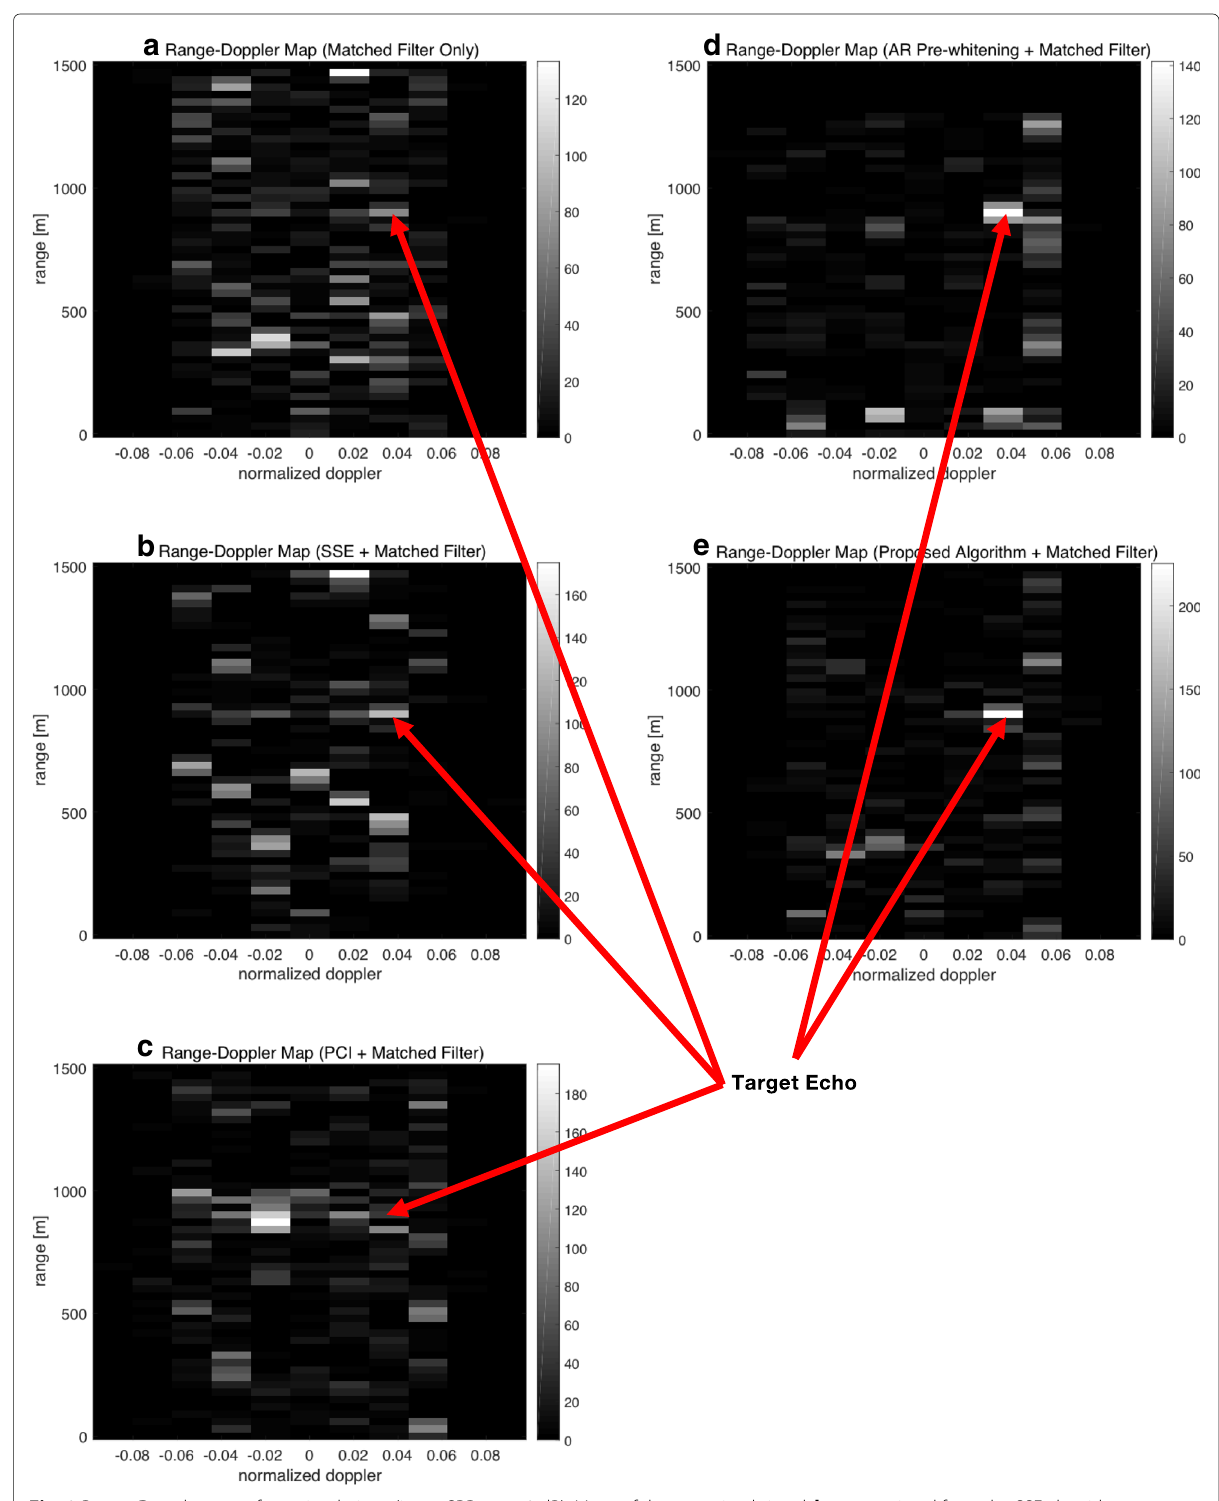
Fig. 9 Range-Doppler maps from simulations (input SRR = − 12 dB). Maps of the a received signal, b output signal from the SSE algorithm, c output signal from the PCI algorithm, d output signal from the AR pre-whitening, and e output signal from the proposed algorithm. Each range-Doppler map is acquired using the block-normalized matched filter